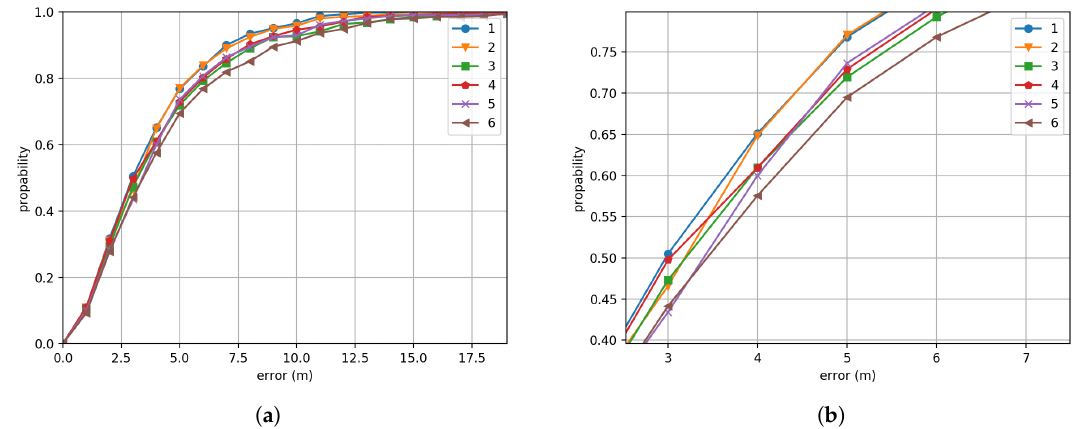
Figure 6. The CDFs of methods with different combinations for Building 1. The legends number correspondences can be found in Table 2. ( a ) CDFs ( b ) Enlarged